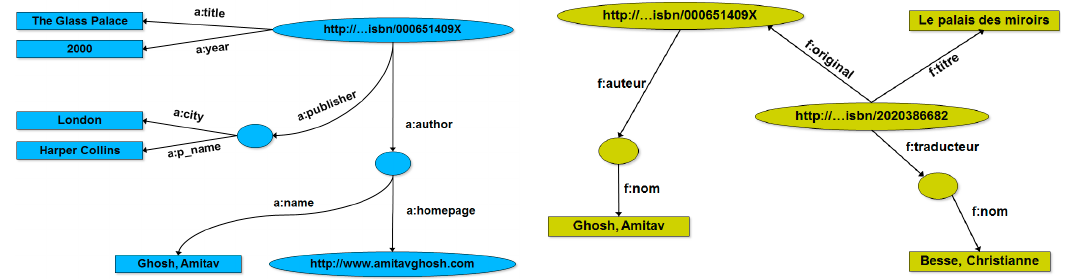
Figure 3. The two RDF graphs corresponding to the two different Web media for the same book reported in Figure 2 [41].